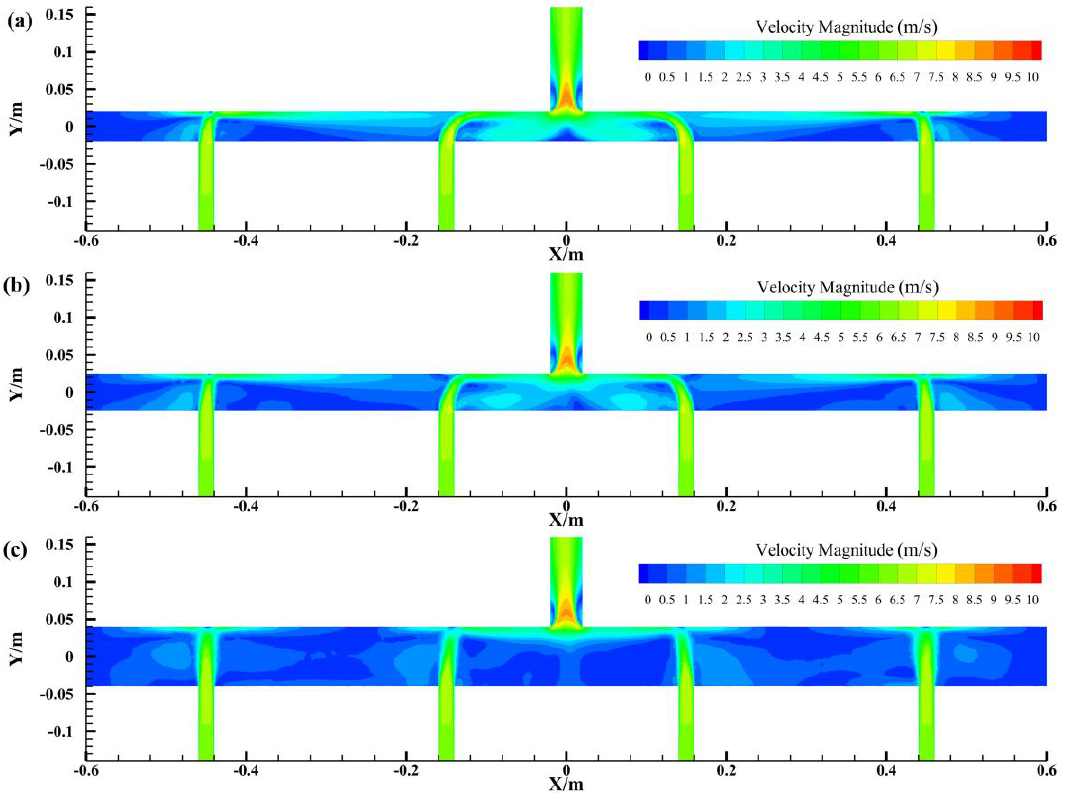
Figure 8. Velocity magnitude contours for configuration “A” cases: ( a ) Dc / d = 2; ( b ) Dc / d = 2.5; ( c ) Dc / d = 4.